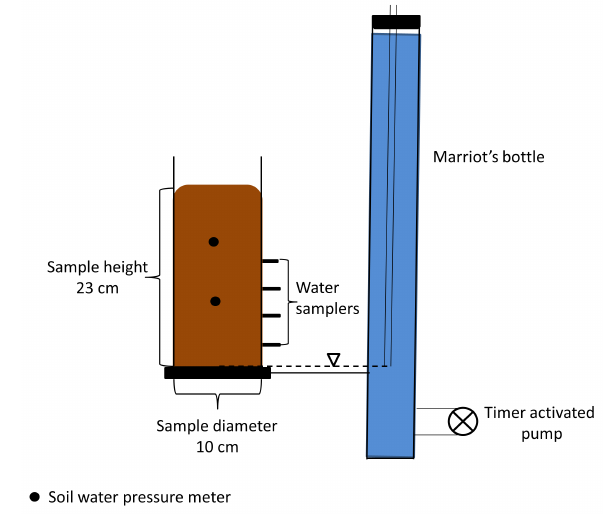
Figure 2. Unsaturated column experiment column and water re- serve